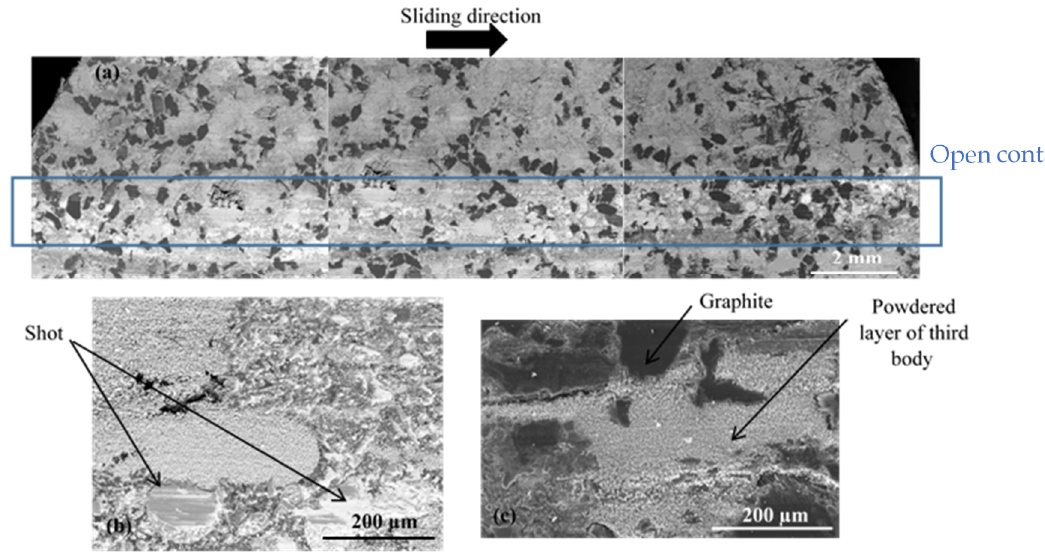
Figure 14. Open contact area at AR (SEM, ( a , b ) BSE and ( c ) SE). Figure 14b,c show rockwool shots and graphite that are shaved and held anchored to the matrix. They constitute primary third-body plateaus, as shown by powdered third-body debris on the surface, surrounded by uncompacted powder Porosities induced by fibre balls, located in the load-bearing zones, especially at the IR, are more filled with third bodies and lined with secondary third-body plateaus up- stream of the fibre balls (Figure 15). Figure 15. Load-bearing zone at IR (SEM, SE) with ( a , b ) porosities induced by fibre balls and ( c ) flat plates.